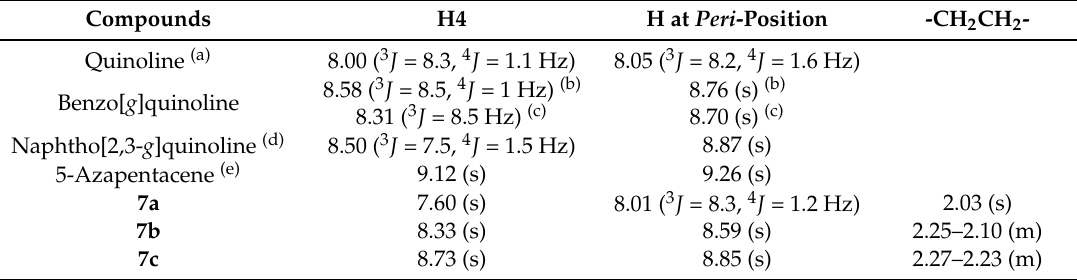
Table 1. 1 H-NMR chemical shifts and coupling constants of selected protons.